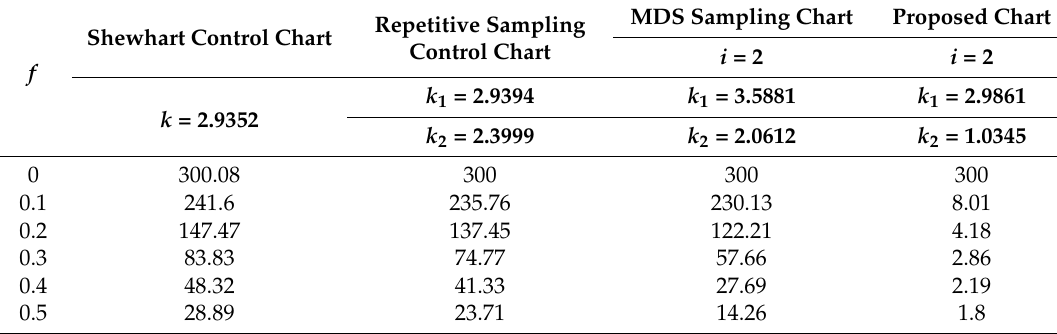
Table 8. ARL comparison when 𝐴𝑅𝐿 = 300,𝑛 = 5,𝑟ℎ𝑜 = 0.6 .